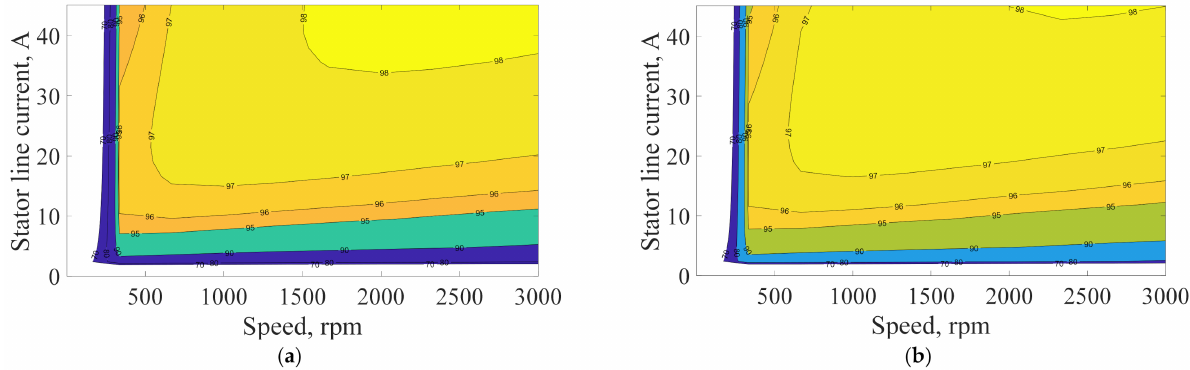
three ‐ phase winding layout. three-phase winding layout.